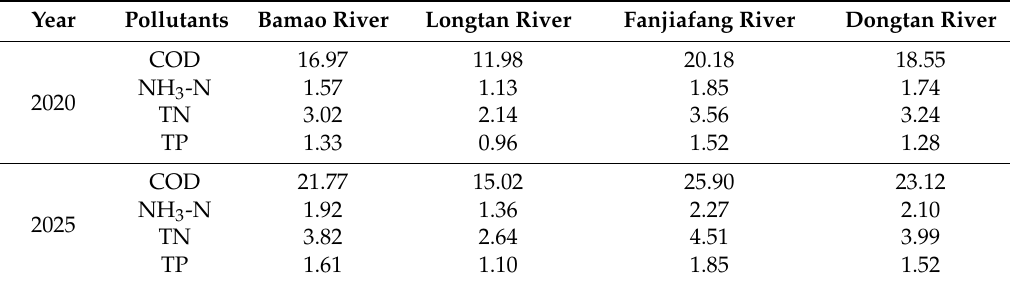
Table 9. The predicted values of the pollutant concentrations in the tributaries of the Huangshi Reservoir in 2020 and 2025 (units: